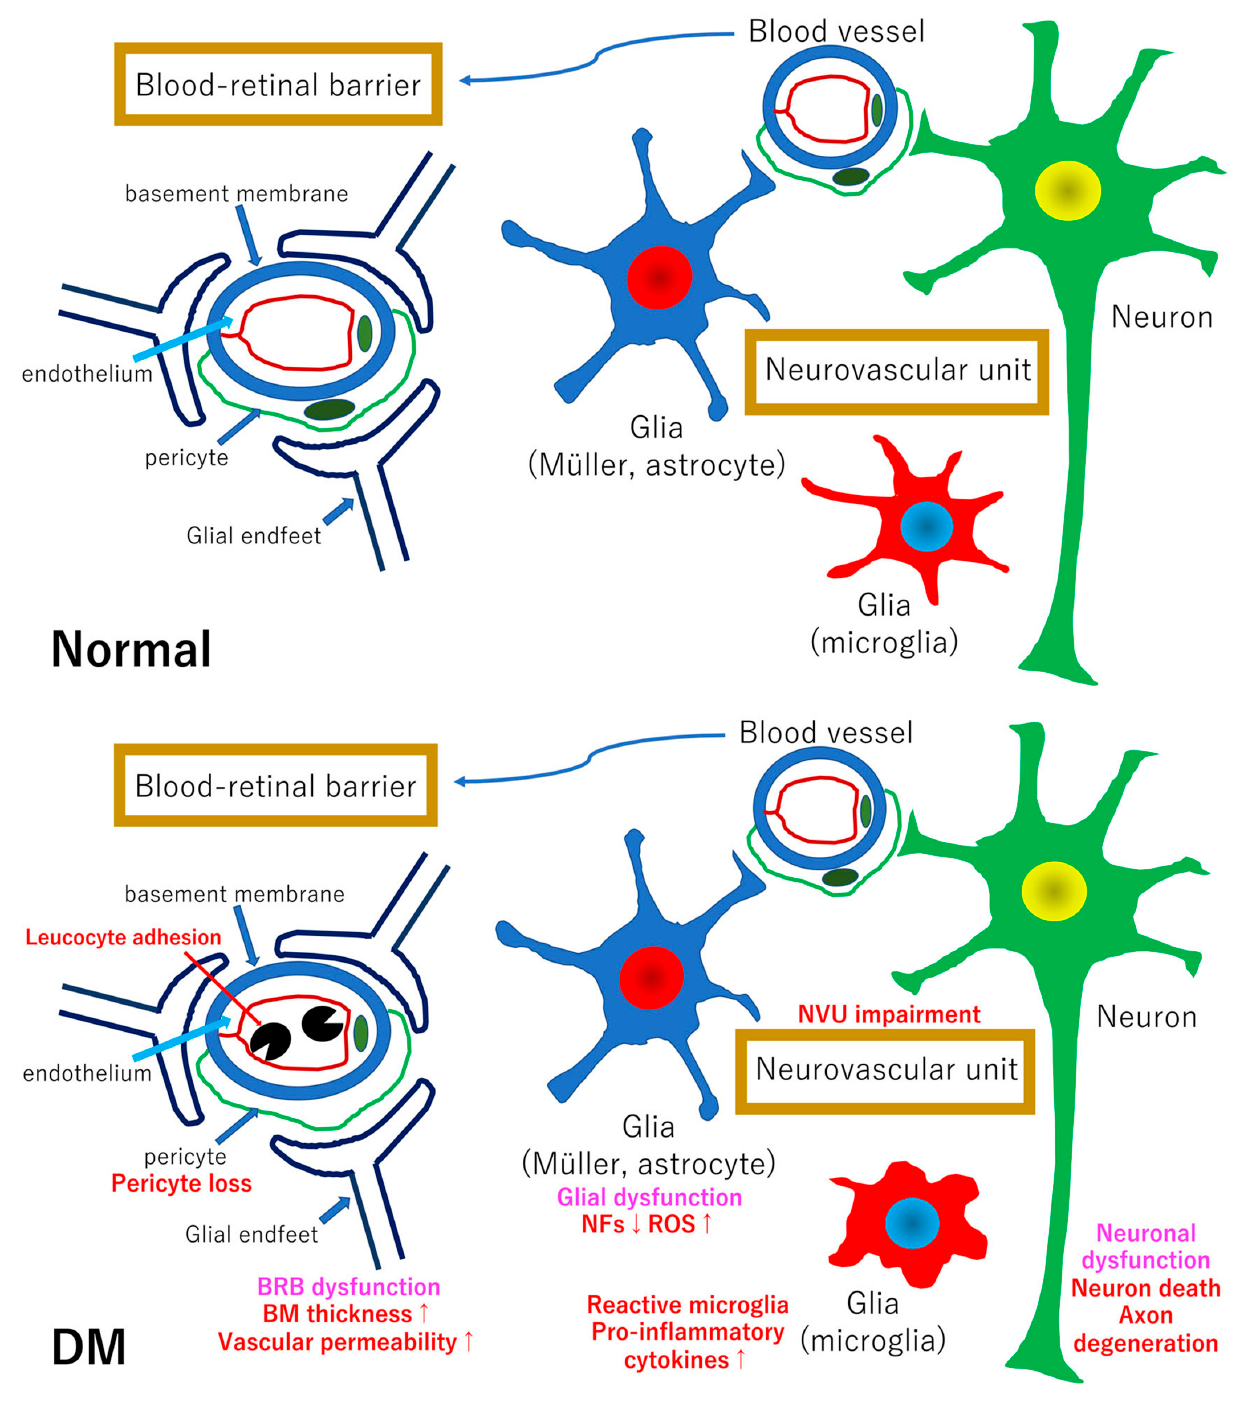
Figure 1. Hypothetical schemes of neurovascular units in normal and diabetic retinas. The upper panel shows the neurovascular unit of the normal retina. Müller cells and astrocytes are involved in the construction of the blood–retinal barrier (BRB) because the endfeets of glial Müller cells and astrocytes are one of the components to maintain the BRB function. However, it was recently reported that microglia to be members of the neurovascular unit. For example, healthy neurons release fractalkine (CX3C ligand 1), which binds to its CX3C chemokine receptor 1 on microglia and regulate microglia repopulation followed by maintaining the retinal homeostasis [53]. Pericytes release platelet-derived growth factor (PDGF) which maintain the BRB, and the loss of PDGF signaling in pericytes may cause neuronal cell death [54]. The lower panel shows the neurovascular unit of diabetic retina. Blood-circulating leukocytes adhere to the surface of endothelial cells via intracellular adhesion molecule-1 and vascular cell adhesion molecule which may cause to the